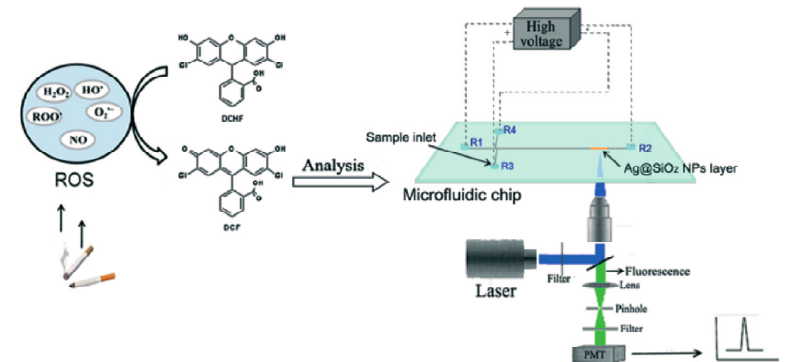
Figure 4. Schematic of the detection system with high sensitivity enhanced by LSPR. The DCHF are loaded into a sample inlet and the ROS is trapped from puffs of cigarette smoke mainstream. The generated DCF is quantified using the microfluidic